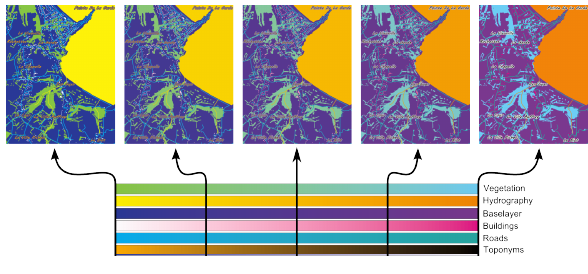
Figure 8: Color specification